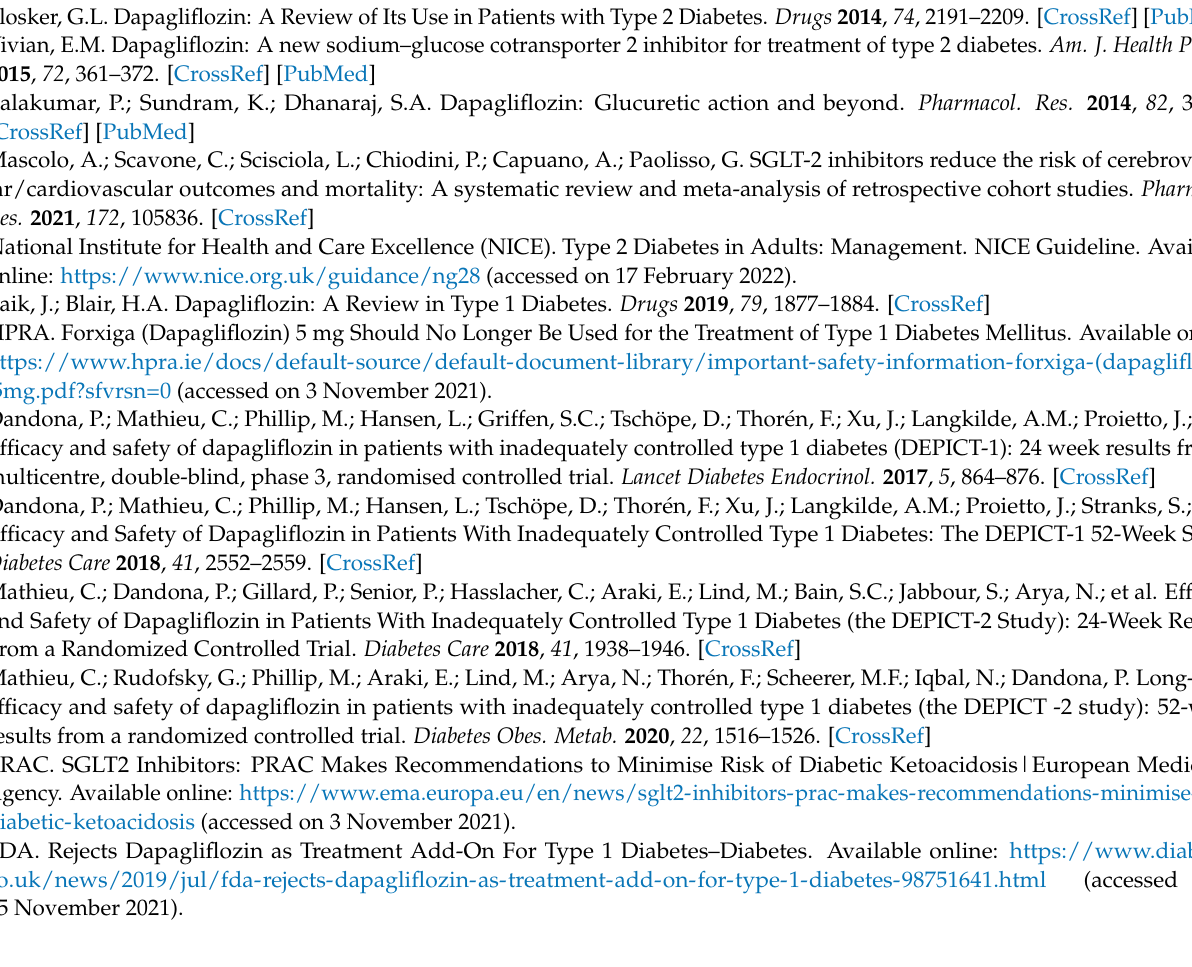
Figure S1: Trend of ketoacidosis adverse events for each type of diabetes mellitus; Figure S2: ke- toacidosis adverse events for type of diabetes mellitus; Figure S3: ROR of ICSRs with ketoacidosis adverse events for dapagliflozin compared to canagliflozin in all diabetes mellitus cases; Figure S4: ROR of ICSRs with ketoacidosis adverse events for dapagliflozin compared to ertugliflozin in all diabetes mellitus cases; Figure S5: ROR of ICSRs with ketoacidosis adverse events for dapagliflozin compared to empagliflozin in all diabetes mellitus cases; Figure S6: ROR of ICSRs with ketoacidosis adverse events for dapagliflozin compared to empagliflozin in T1DM; Figure S7: ROR of ICSRs with ketoacidosis adverse events for dapagliflozin compared to canagliflozin in